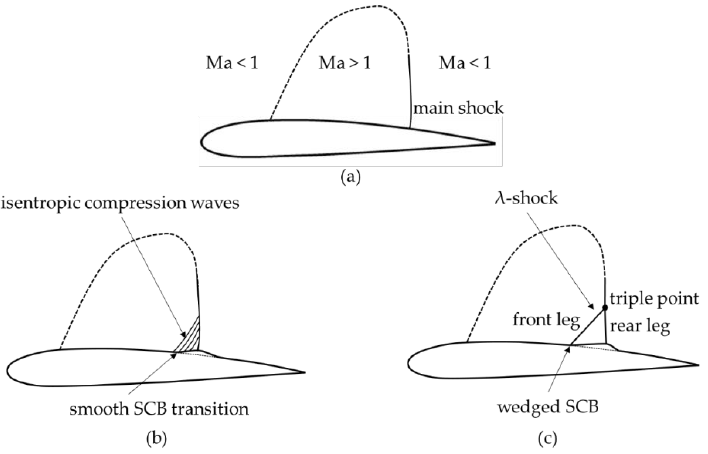
Figure 1. Aerodynamic principle to mitigate the transonic shock ( a ) by using a shock control bump (SCB) with smooth transition ( b ) or wedged bump with a kink to form the λ-shock structure ( c ) based on [25] and [15] (Ma: Mach number).